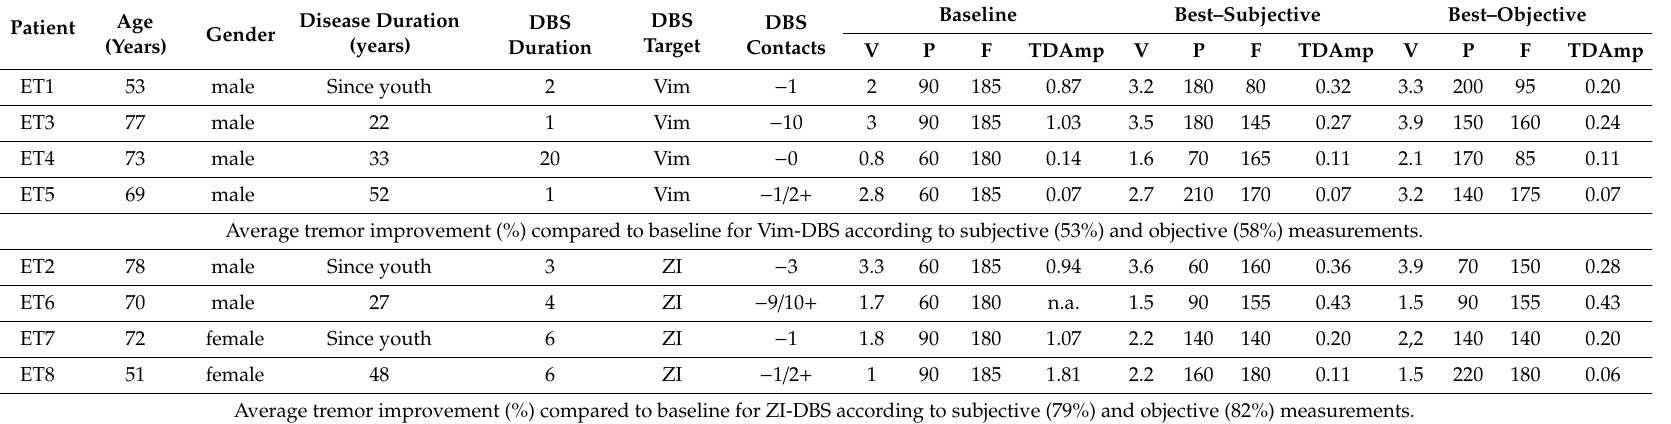
Table 1. Patient demographics and deep brain stimulation (DBS) parameters. Baseline tremor control was measured prior re-titration with the patients retaining their current DBS settings. Next, ten random combinations of stimulation parameters were tested in eight essential tremor (ET) patients. The random combinations a ff ording the most tremor suppression according to both patient-reported outcomes (subjective) and accelerometer recordings (objective) are presented here. Tremor severity is expressed in arbitrary units (TDAmp) as returned by the accelerometer. “Since youth” implies that the patients were diagnosed before the age of 18 years old.